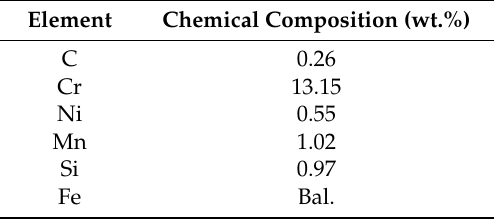
Table 1. Chemical composition of the AISI 420 SS Powder (wt.%). Element Chemical Composition